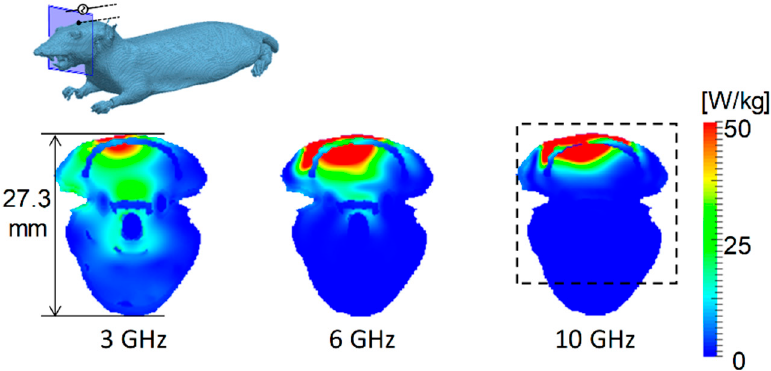
Figure 2. Specific absorption rate (SAR) distributions in the rat model at 3, 6, and 10 GHz. The distance between the skin surface and the dipole antenna was set to 5 mm. The output power of the antenna was adjusted so that the peak SAR averaged over 10-g tissue was equal to 10 W/kg. The dashed square shows the region with a computed peak of 10-g SAR.